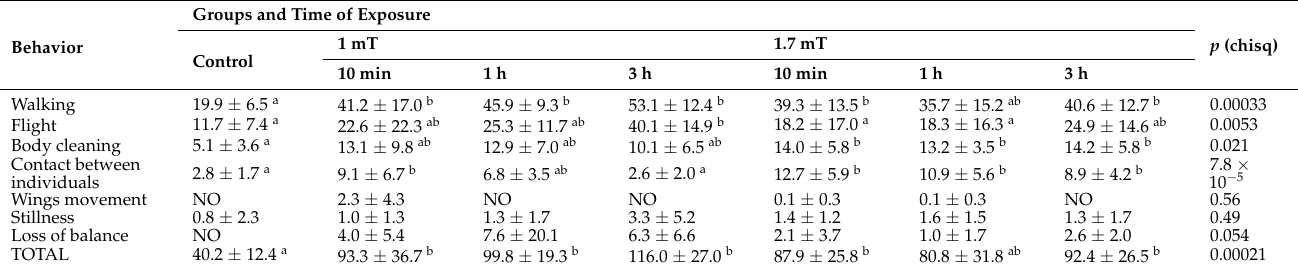
Table 2. Mean number of bouts ± SD, different letters within same behavior—significant differences (Kruskal–Wallis test, p < 0.05), NO—not observed. NO values per group were not included in statistical analysis in any